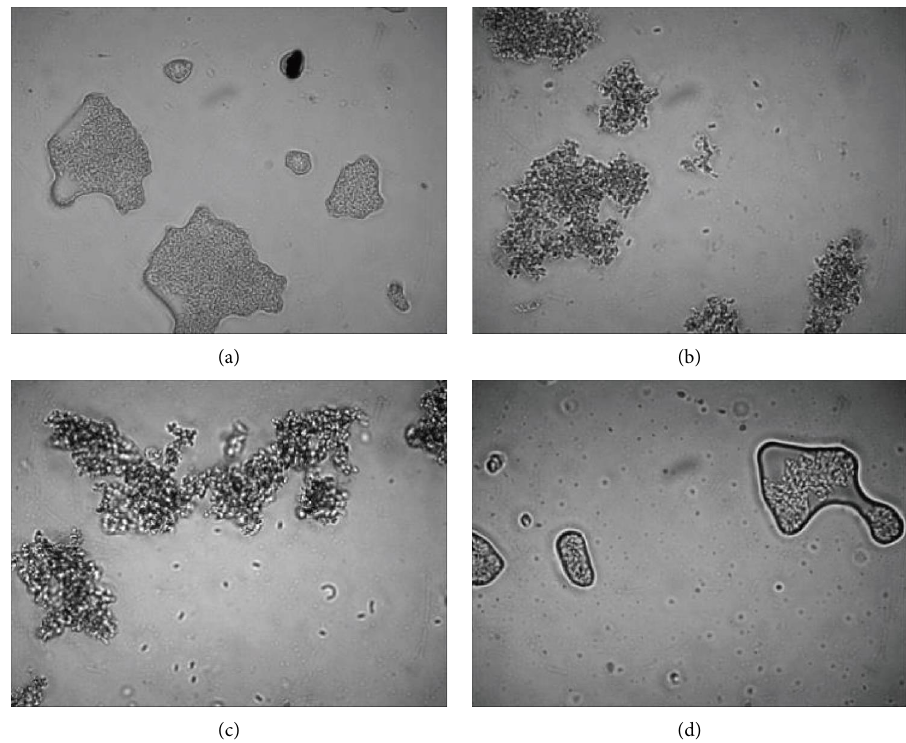
Figure 5: Microscopic appearance of hydrogel containing L. acidophilus FNCC 0051 (1300x magnifcation) during exposure to gastric juice for (a) 0 min, (b) 30min, (c) 60min, and (d)